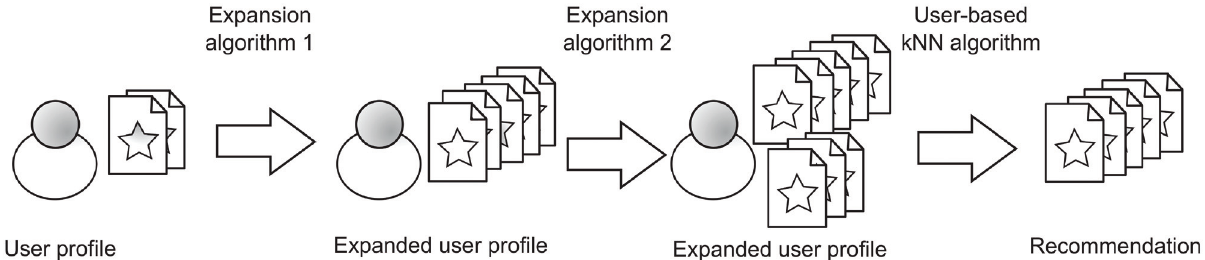
Fig 2. Recommendation process using High Order Profile Expansion with the serial